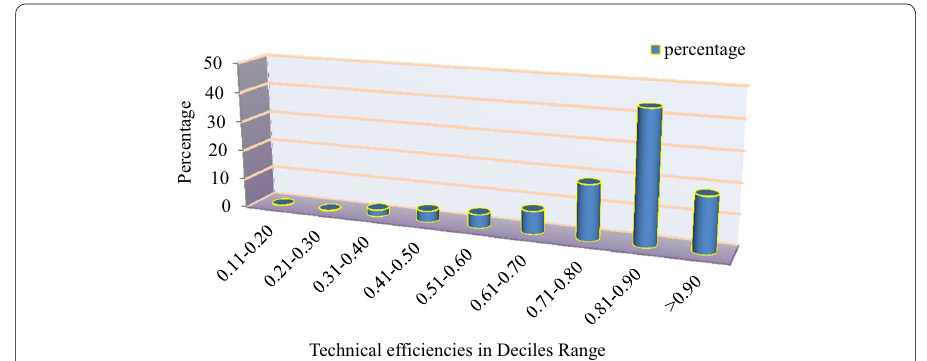
Fig. 3 Frequency distribution of technical efficiency Source : Own survey result